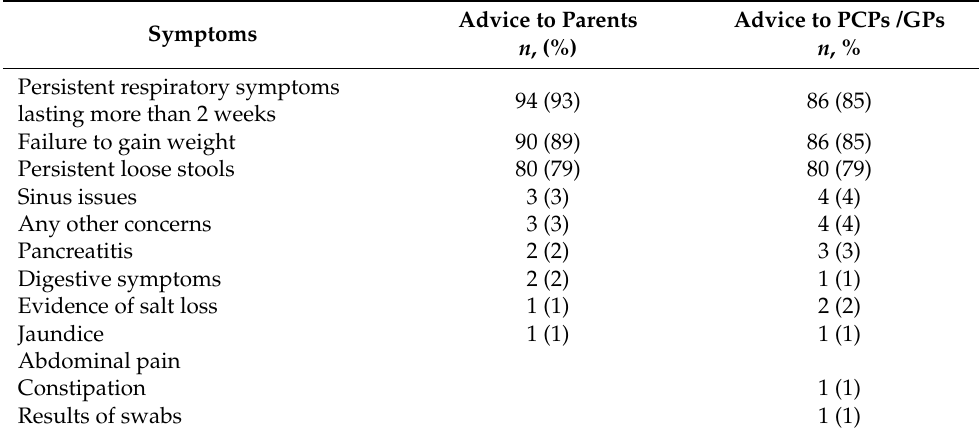
Table 4. Advice for parents and primary care practitioners (PCPs)/general practitioners (GPs) regarding when parents should seek medical